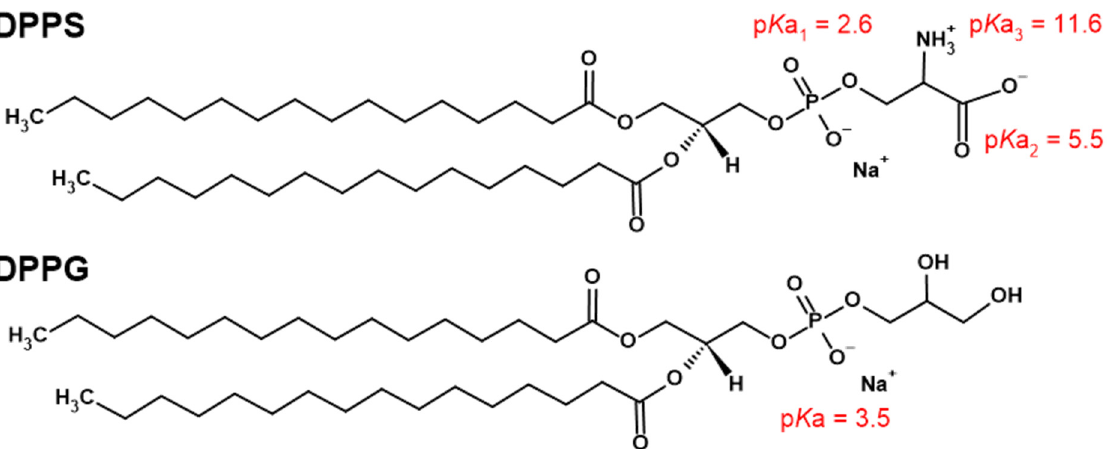
Figure 1. Structural formulas and p K a values of particular titrable functional groups of 1,2-dipalmitoyl- sn -glycero-3-phospho-L-serine (DPPS) and 1,2-dipalmitoyl- sn -glycero-3-phosphoglycerol (DPPG) [18,20].